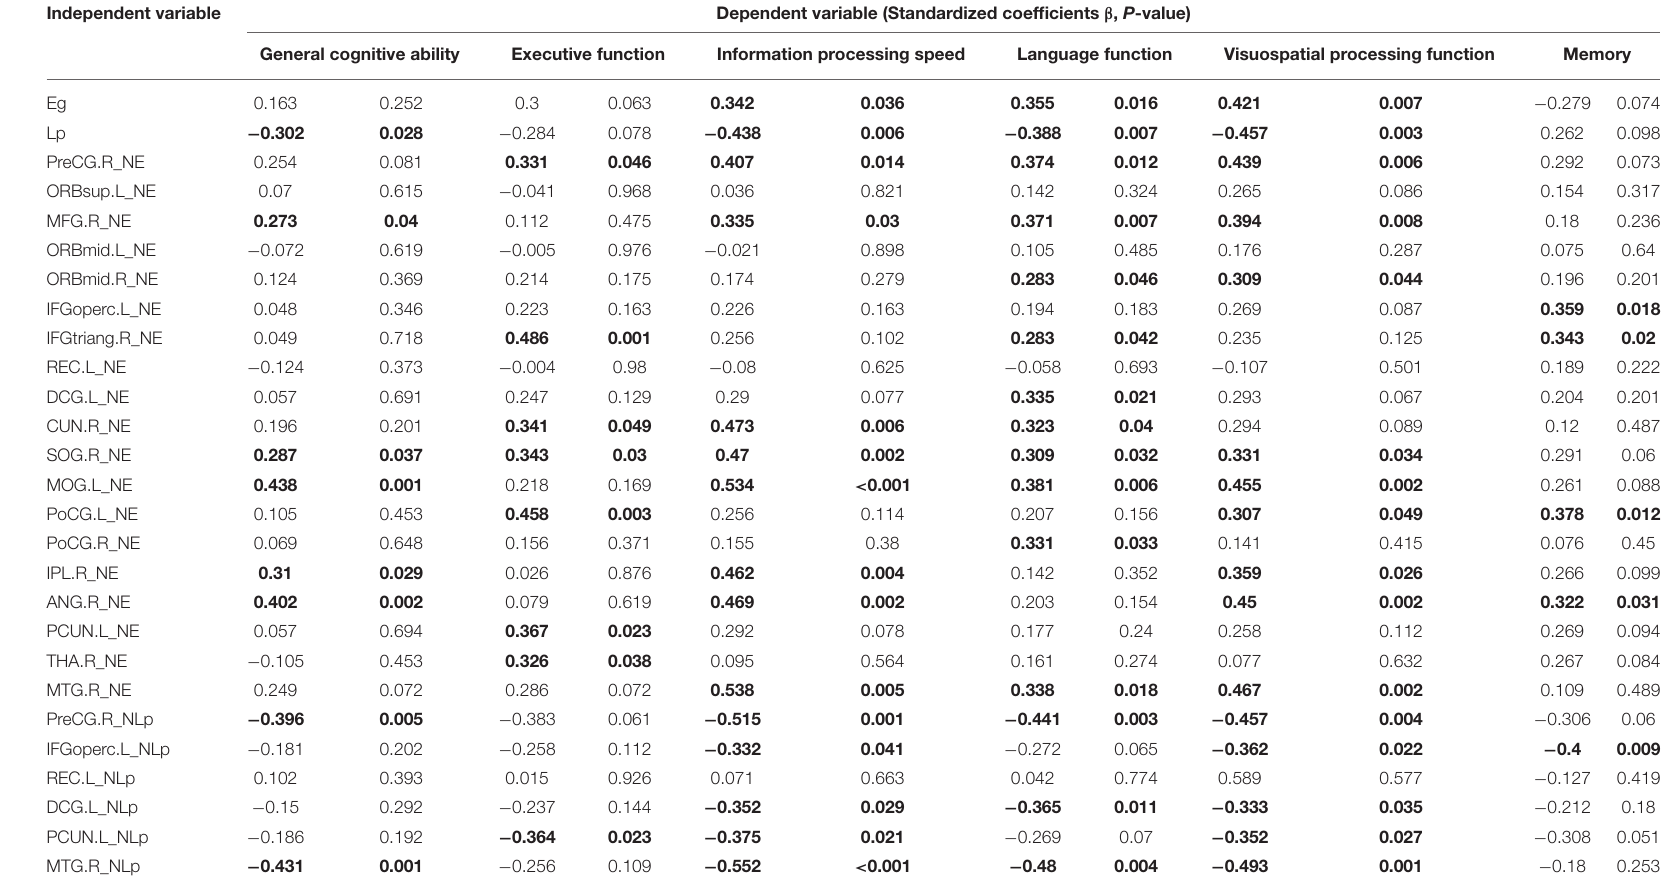
TABLE 4 | Multiple linear regression analyses of network metrics and cognitive function in